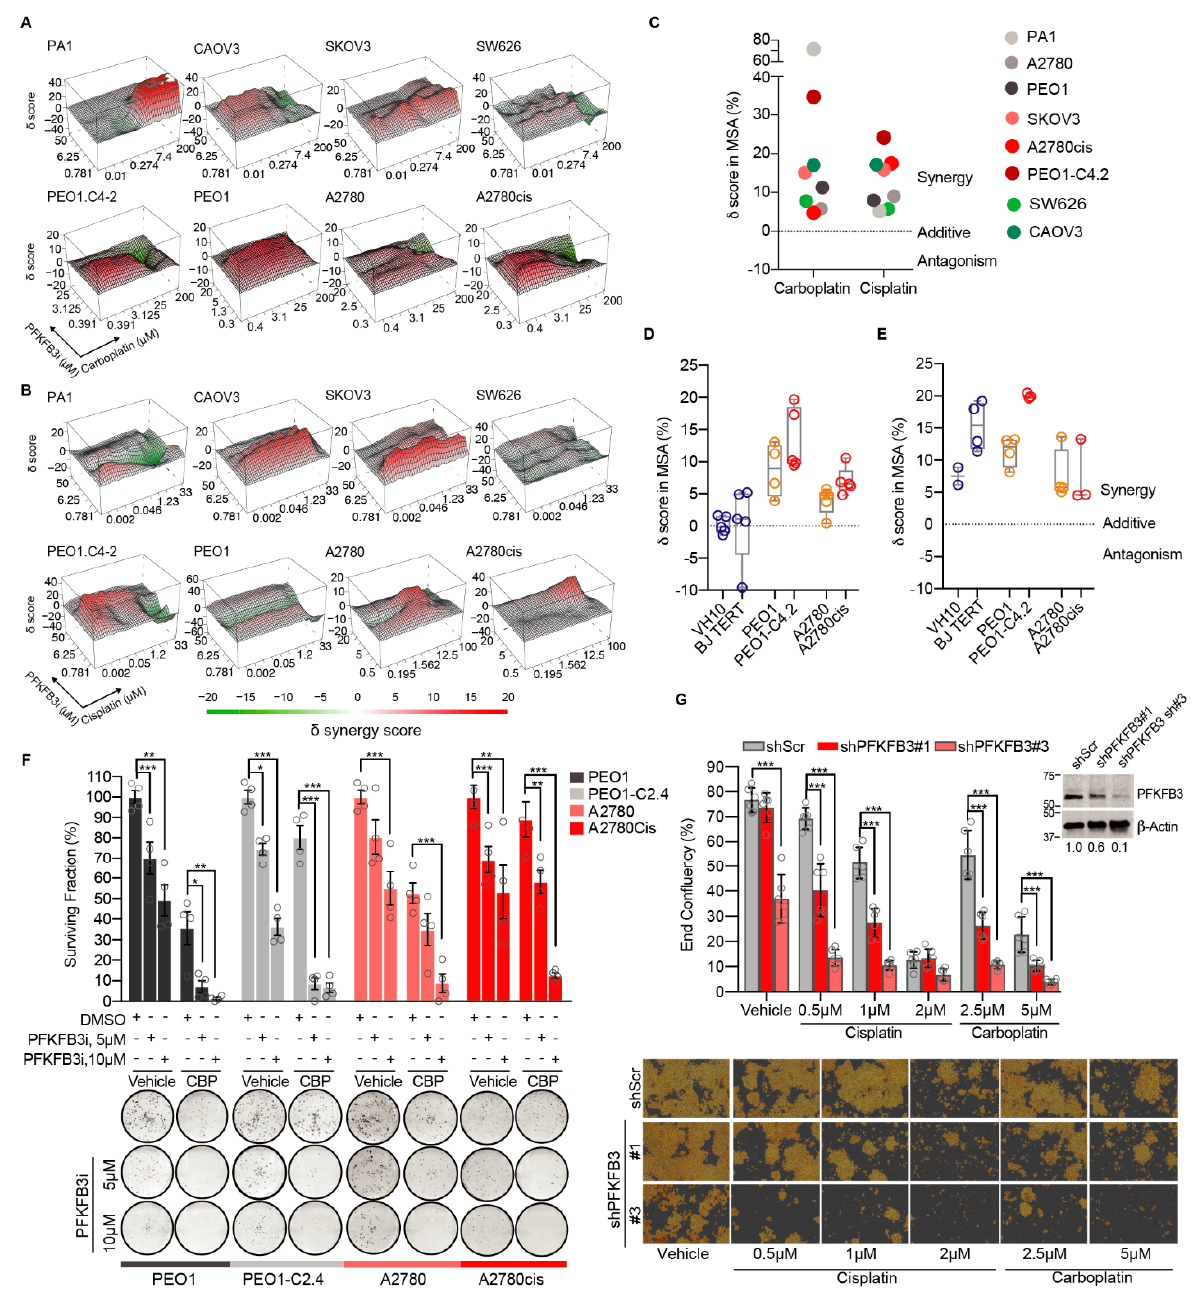
Figure 1. Targeting PFKFB3 enzymatic activity resulted in a non-reversible cancer-specific synergy with platinum drugs. ( A – B ) Three-dimensional heatmaps of the synergy surface of dose-response viability matrixes upon carboplatin ( A ) or cisplatin ( B ) in combination with PFKFB3 inhibitor (PFKFB3i) for 72 h. Representative graphs from initial screening across eight different cancer cell lines. Synergy scores were calculated by the zero interaction potency model and images were generated by Synergy Finder (version 2.0). ( C ) Scatter dot plot of delta scores in the most synergistic area (MSA) from each synergy matrix of ( A ) and ( B ). ( D ) Delta scores in the MSA upon carboplatin treatment in combination with PFKFB3i in